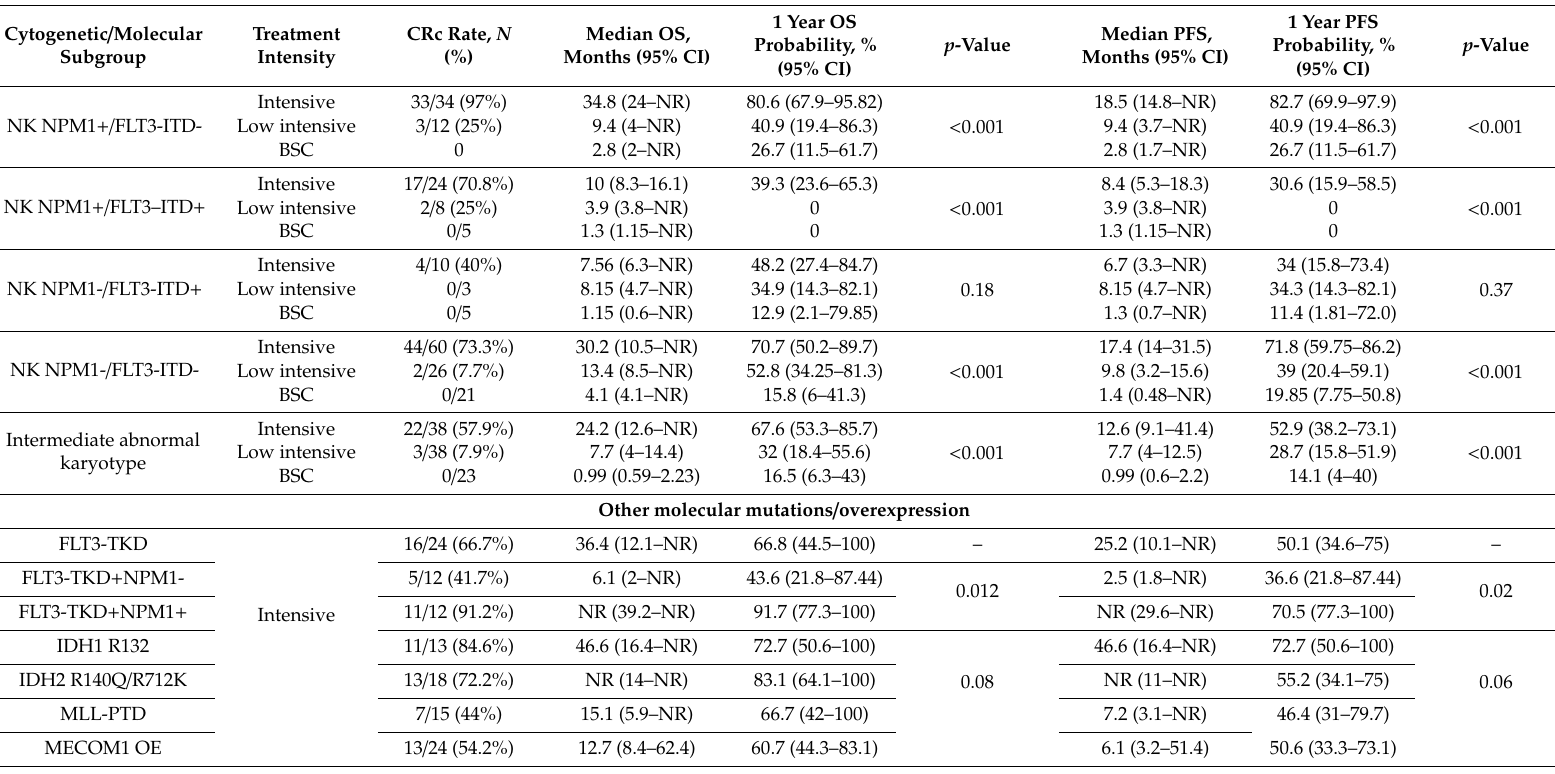
Table 3. Overall outcome of favorable NK NPM1 + patients, intermediate risk patients with NK according to their NPM1 / FLT3-ITD status or with abnormal karyotype, and in patients harboring other molecular